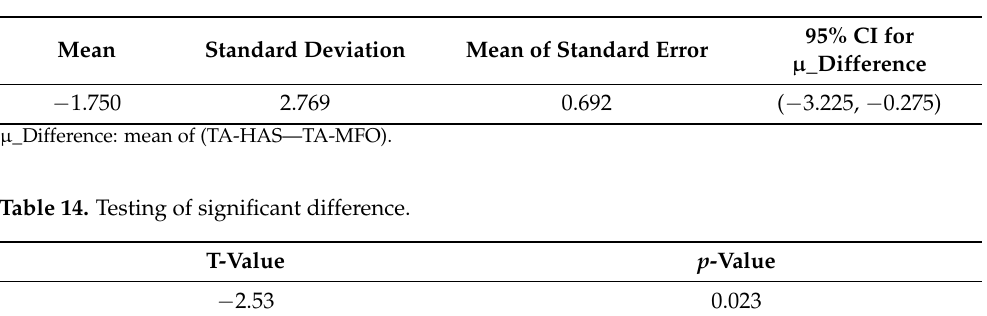
Table 13. Estimation for paired difference.